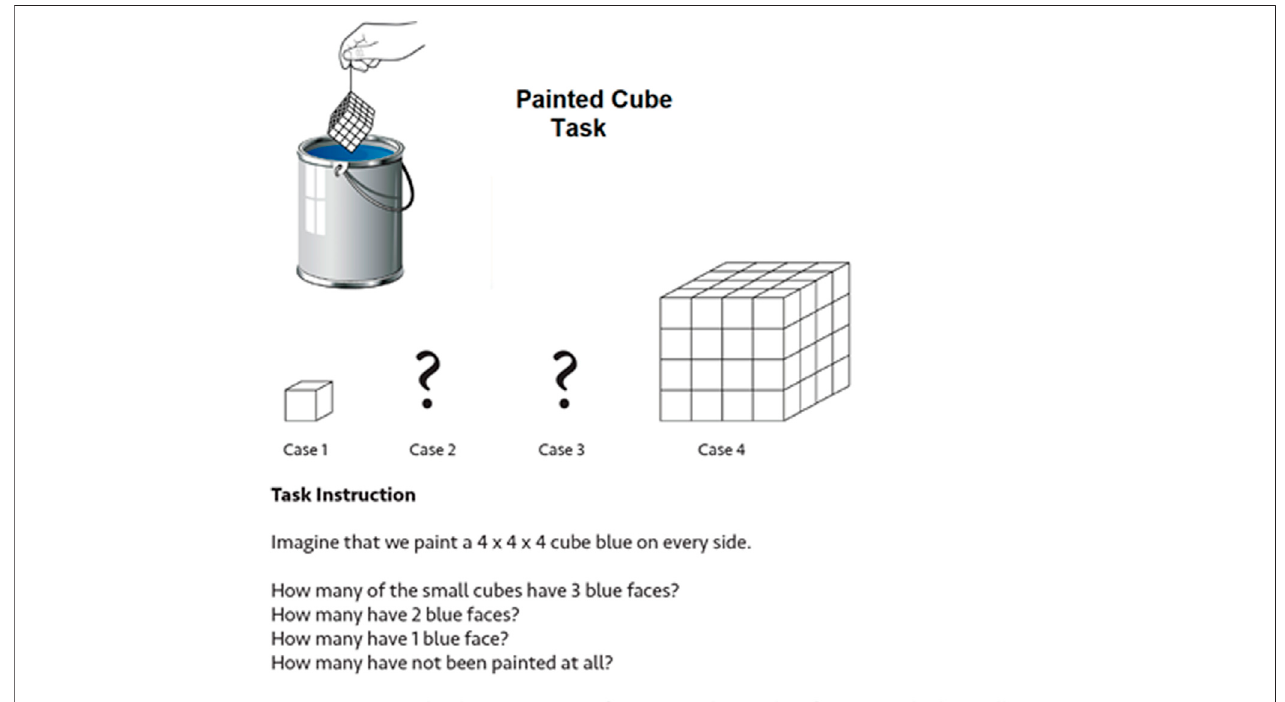
FIGURE 2 | Painted cube